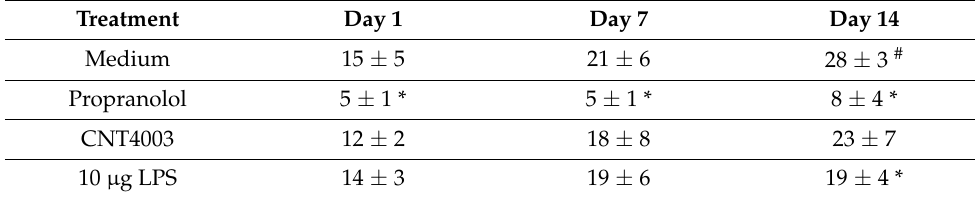
Table 5. Ciliary beating frequency (Hz) in MucilAir™ tissues after exposure to control, lipopolysac- charide (LPS) or 25 µ g CNT4003. Significant ( p < 0.05) differences in the medium-treated group at different time points are indicated by an asterisk and differences of the treatment to the medium control with a hash.